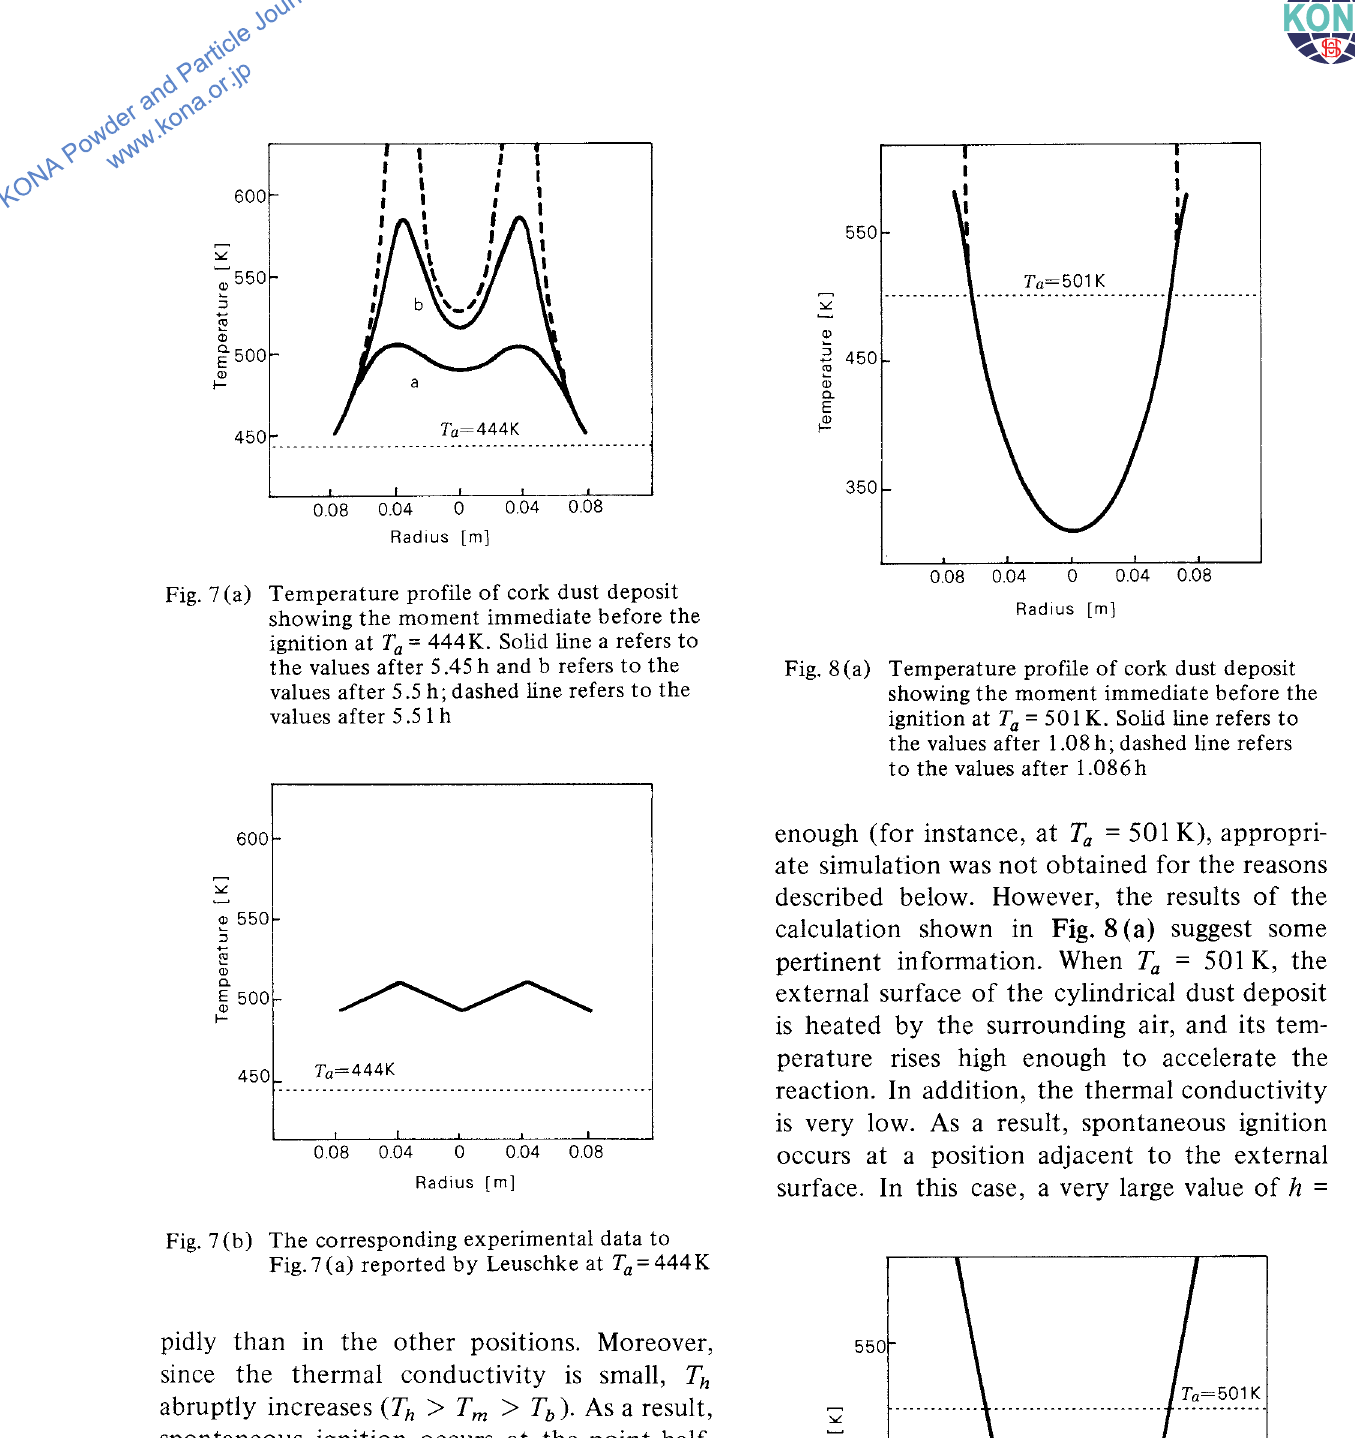
Fig. 7 (a) Temperature profile of cork dust deposit showing the moment immediate before the ignition at Ta = 444K. Solid line a refers to the values after 5 .45 h and b refers to the values after 5.5 h; dashed line refers to the values after 5 .5 1 h